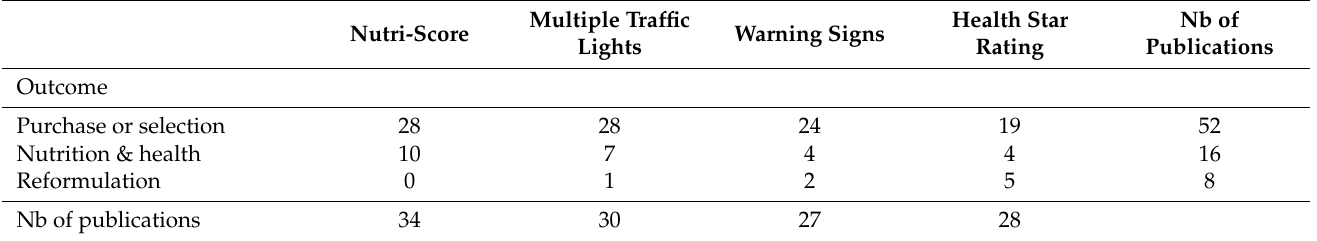
Table 2. Number of original studies sorted by FOPNL and by outcome. Note that a same study can address several FOPNL and/or several